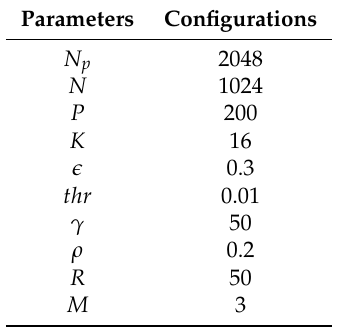
Table 1. Parameters in